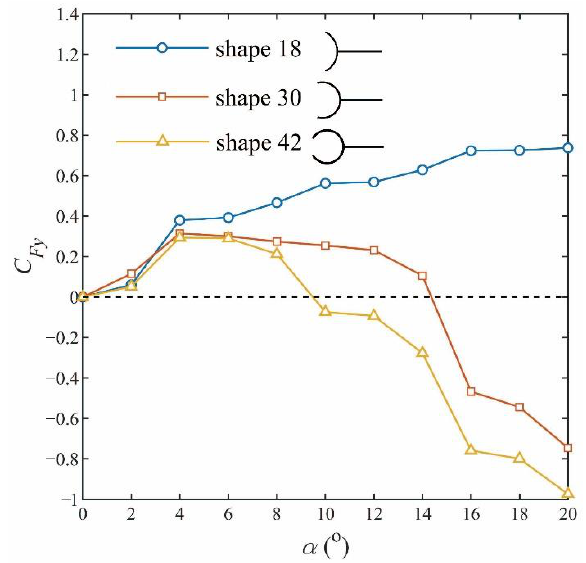
Figure 11. Variation of transverse force coefficient C Fy with wind attack angle α for bluff bodies with different arc angles.